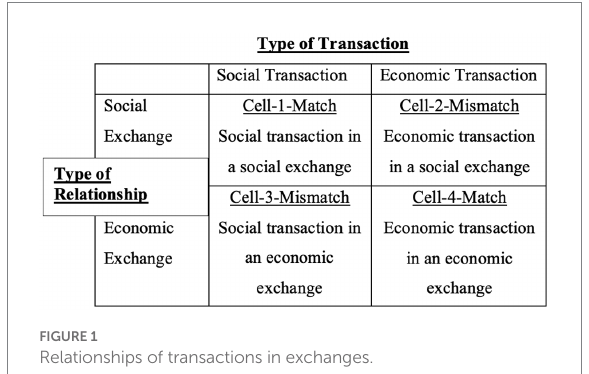
FIGURE 1 Relationships of transactions in